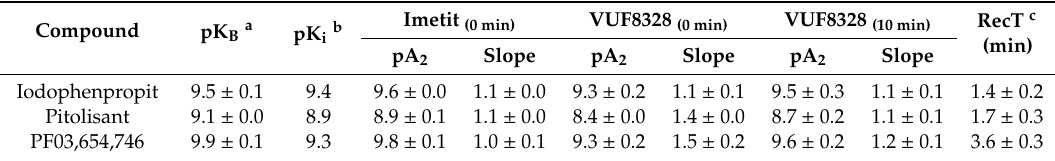
Table 2. Equilibrium dissociation constants (pK B ), pA 2 -values and slopes from Schild-regression and recovery time of ligands in hH 3 R-mediated G α i2 activation in HEK293T cells measured as recruitment of Venus-G β 1 γ 2 to masGRK3ct-Nluc. Data shown are mean ± S.E.M. of three experiments performed in triplicate except for RecT, which was measured in